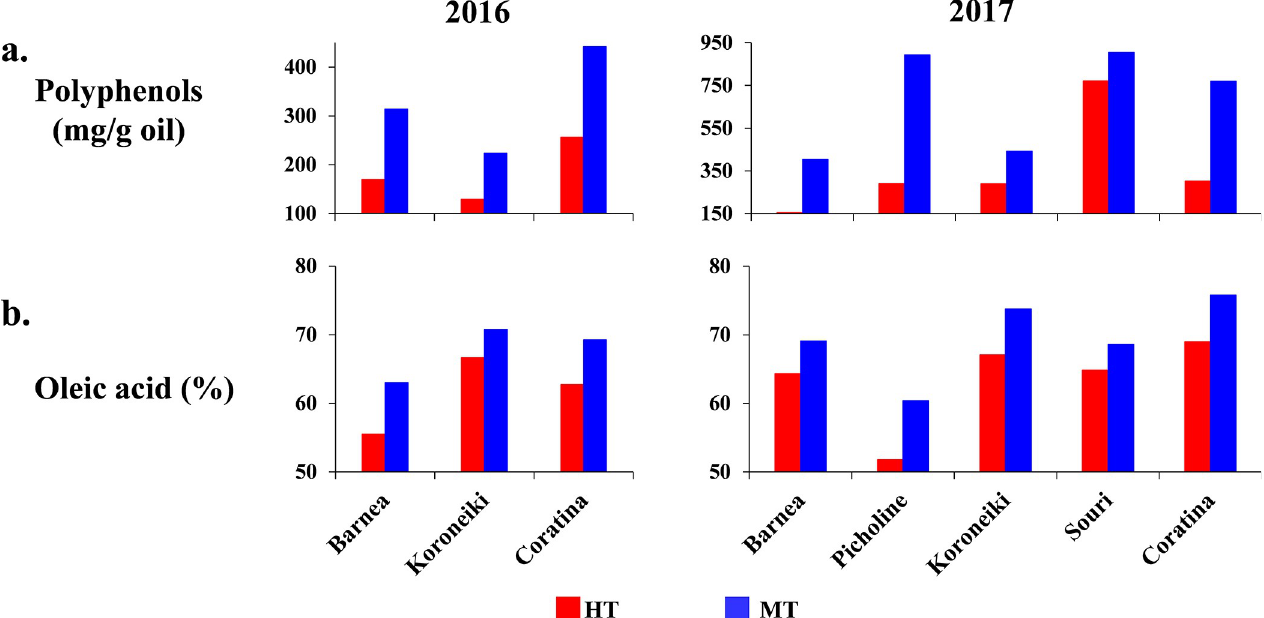
Fig 5. Oil quality, represented by polyphenol (a) and oleic acid (b) levels in the oil extracted from the various cultivars in the two climatic regions, during both years.